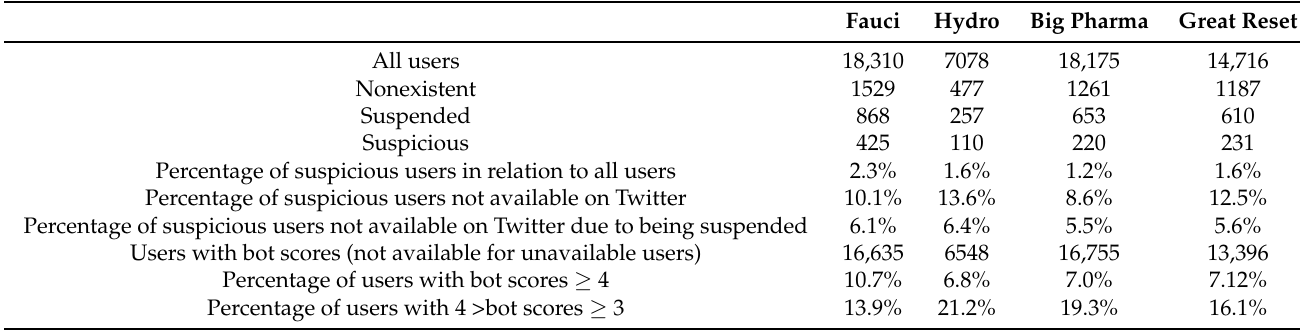
Table 10. Quantitative analysis of suspicious users for the four COVID-19-related use